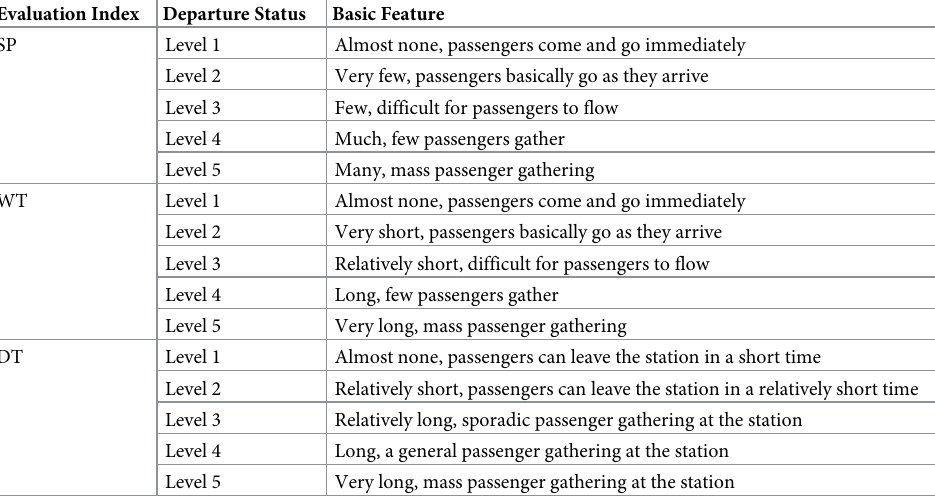
Table 6. Description of departure state levels corresponding to each evaluation